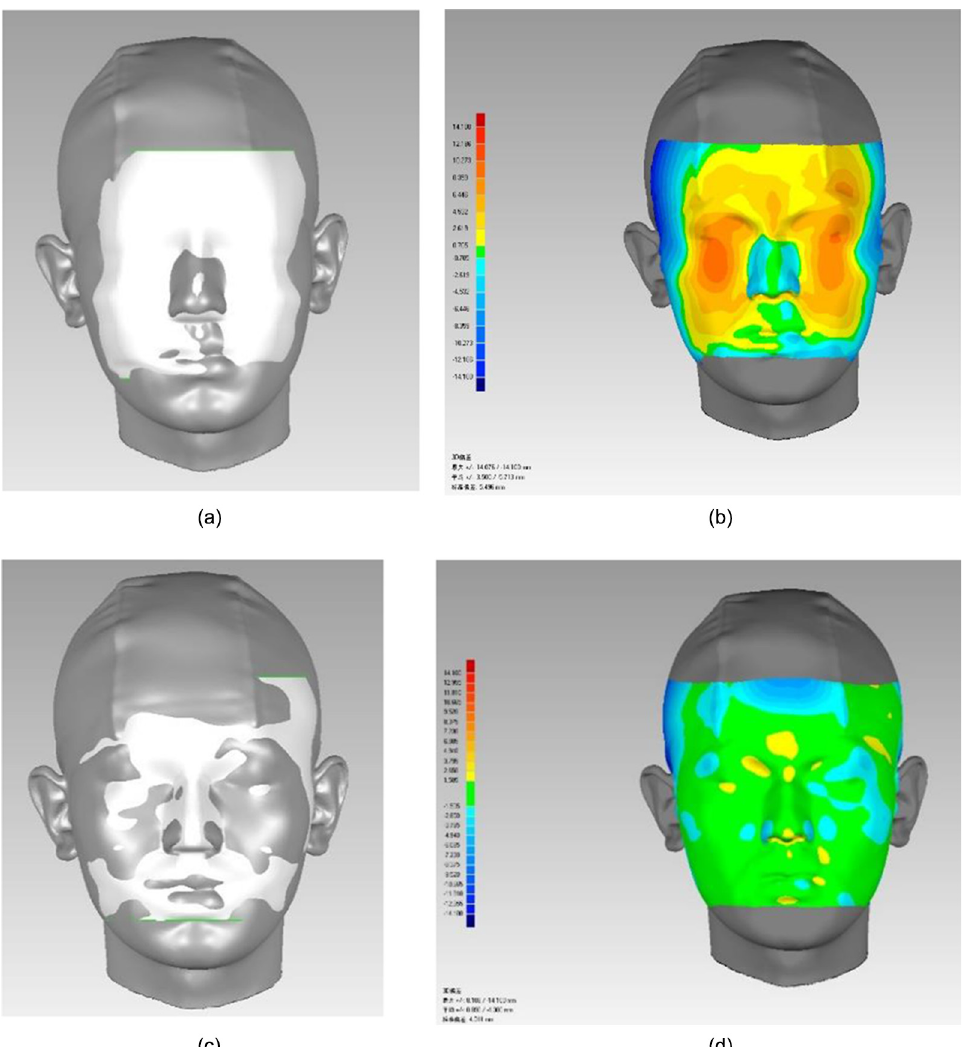
Fig. 18. Veri fi cation of the accuracy of parametric modeling of the head of the